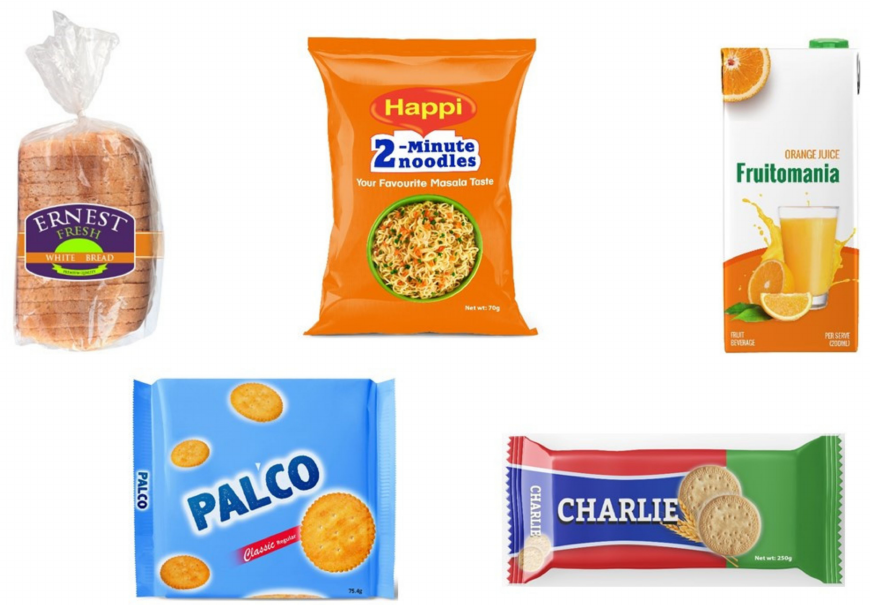
Figure A1. Images of products used without